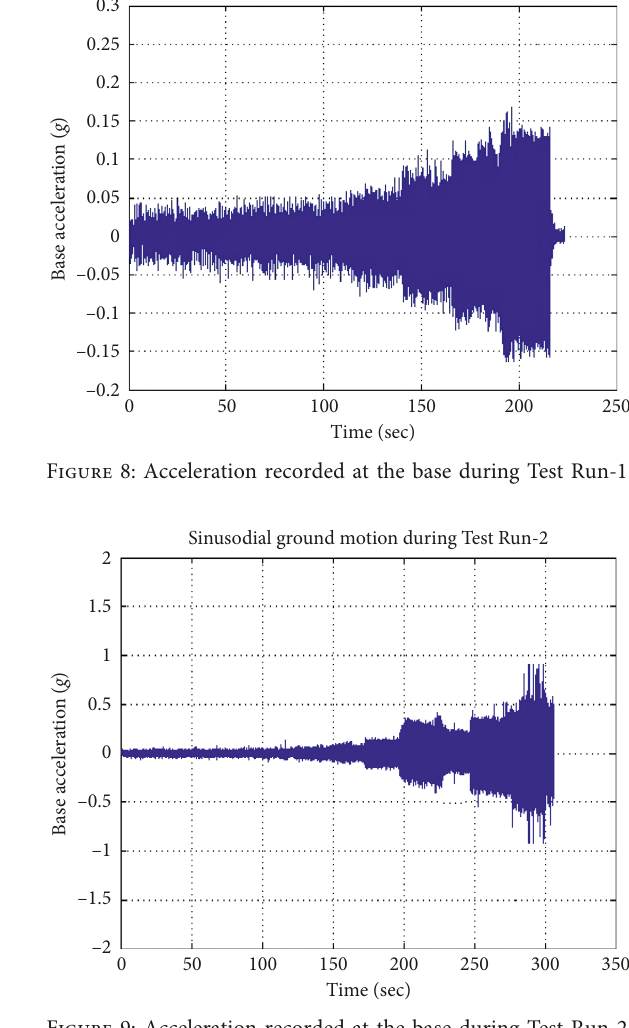
Table 2: Average material properties.